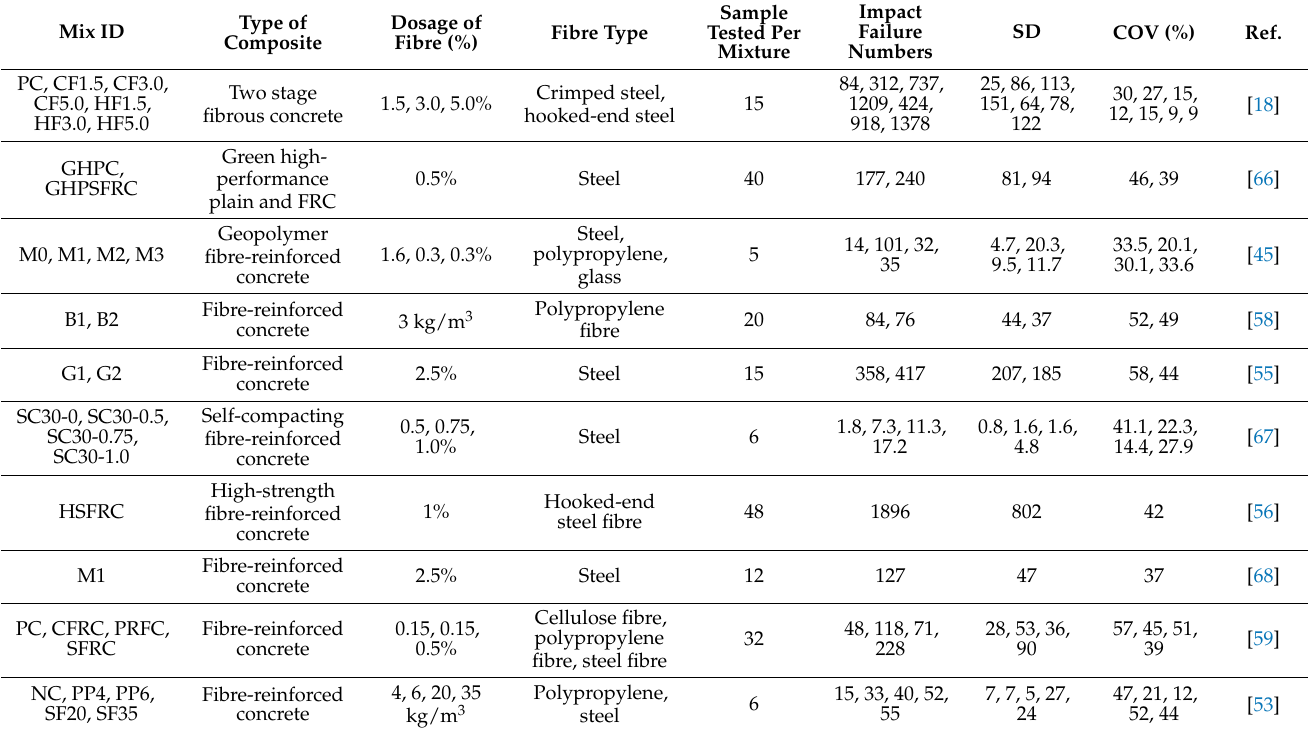
Table 1. The outline of the pilot experience of the ACI Committee, with and without fibres, for falling-mass impact outcomes on